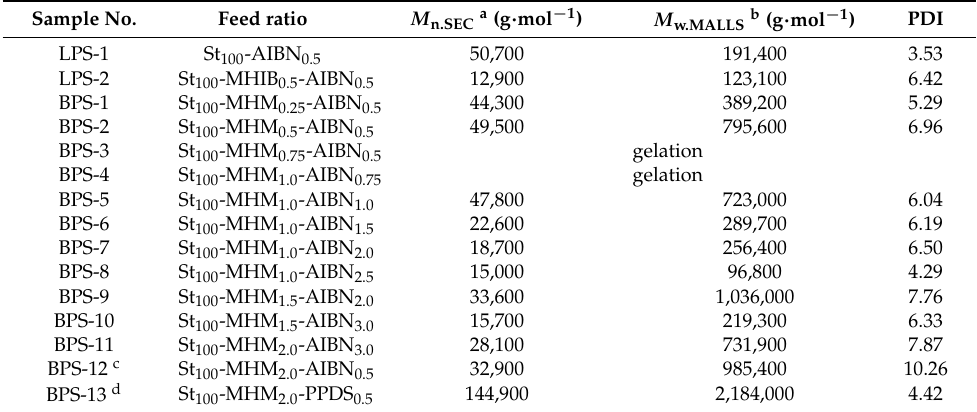
Table 1. Triple Detection Size Exclusion Chromatography (TD-SEC) results of the obtained polymers. Sample No.